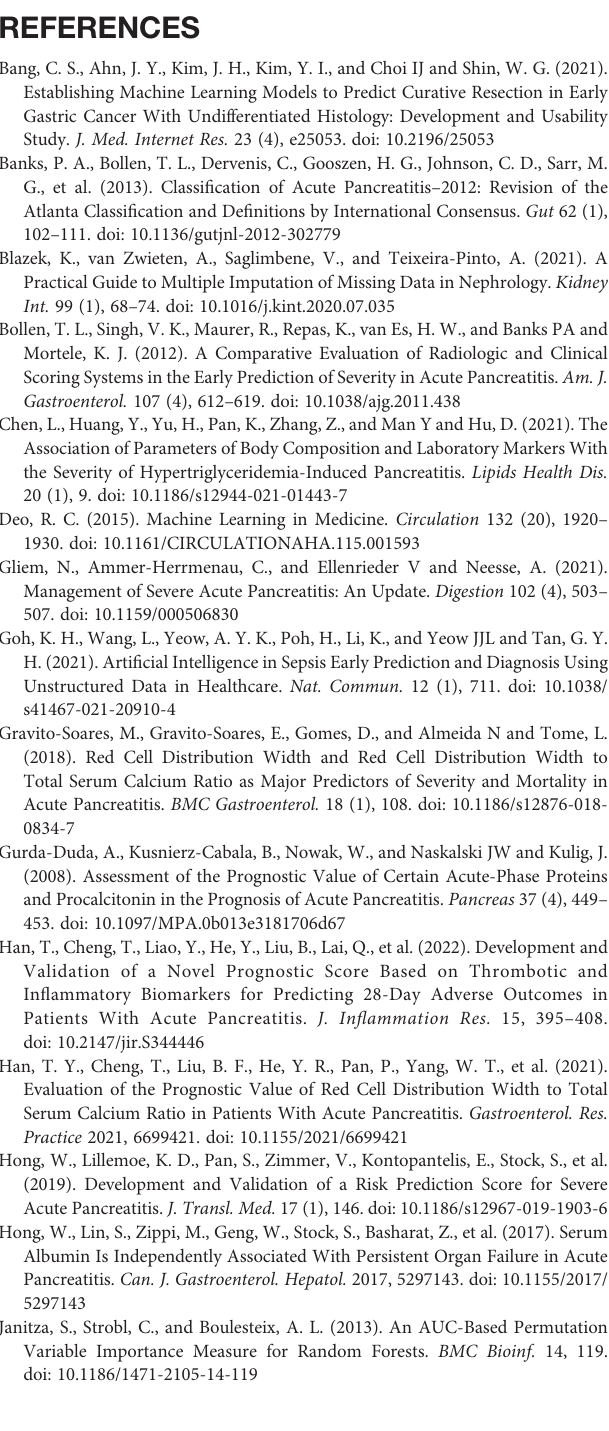
threshold probability of SAP predicted by the LASSO model was between 10% and 100%, an intervention might add more bene fi t (6-10%). Supplementary Figure 4 | ROC curvesofallproposed models (GBMand LASSO models)andtraditionalscoringsystems(BISAP,MCTSI,RANSONandSABP).GBM, Gradient Boost Machine; LASSO, the Least Absolute Shrinkage and Selection Operator; BISAP, bedside index of severity in acute pancreatitis; MCTSI, modi fi ed computed tomography severity index; RANSON, RANSON score;